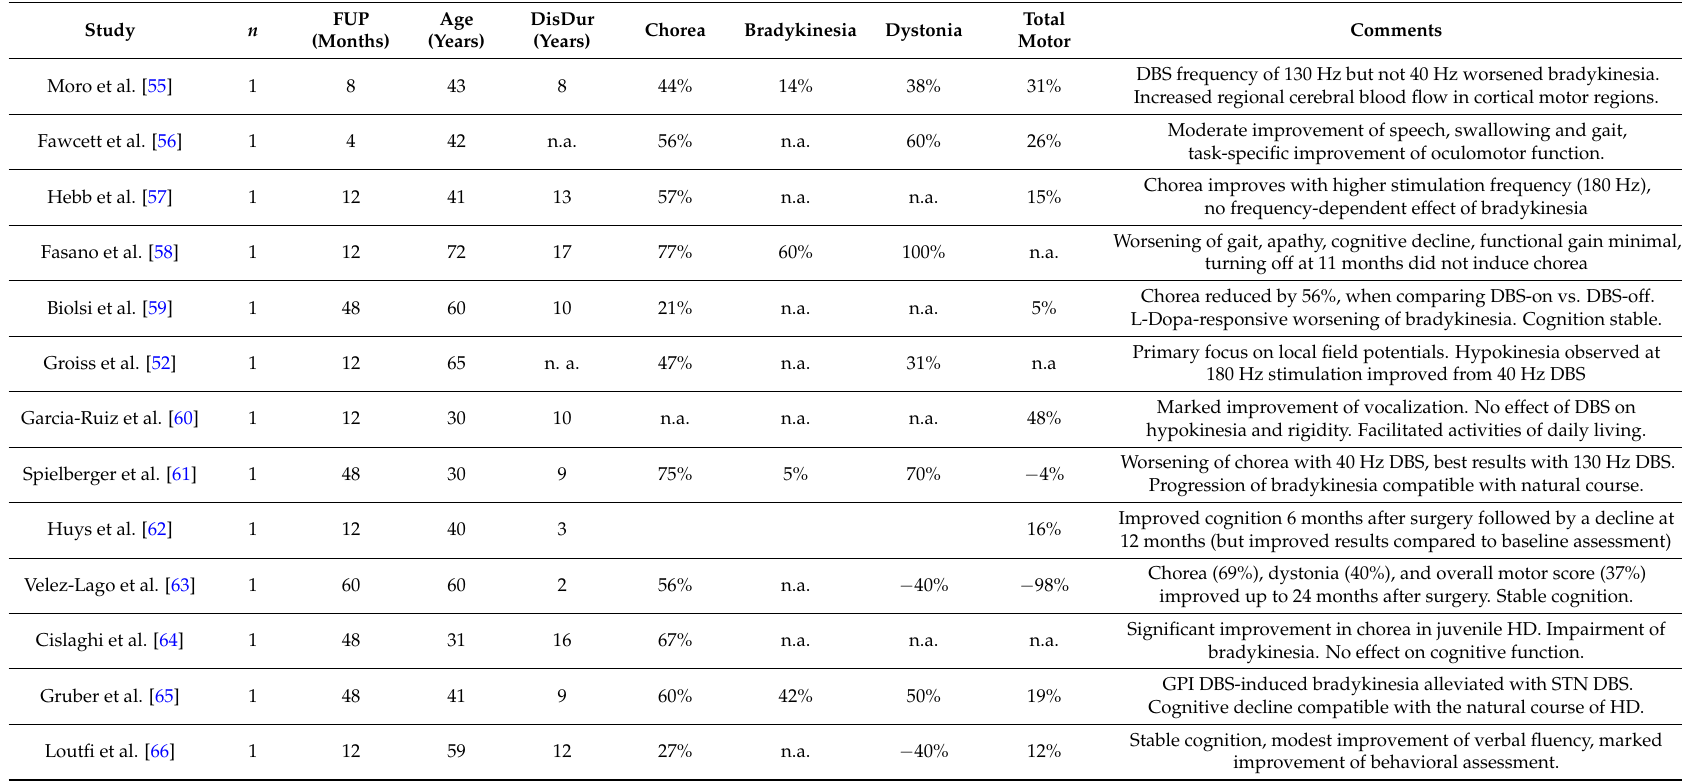
Table 1. Case reports ( n = number of patients) of DBS in